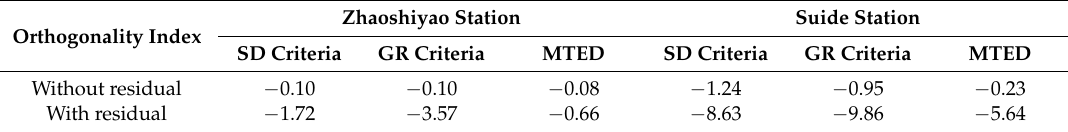
Table 1. Orthogonality index of runoff components based on three stopping